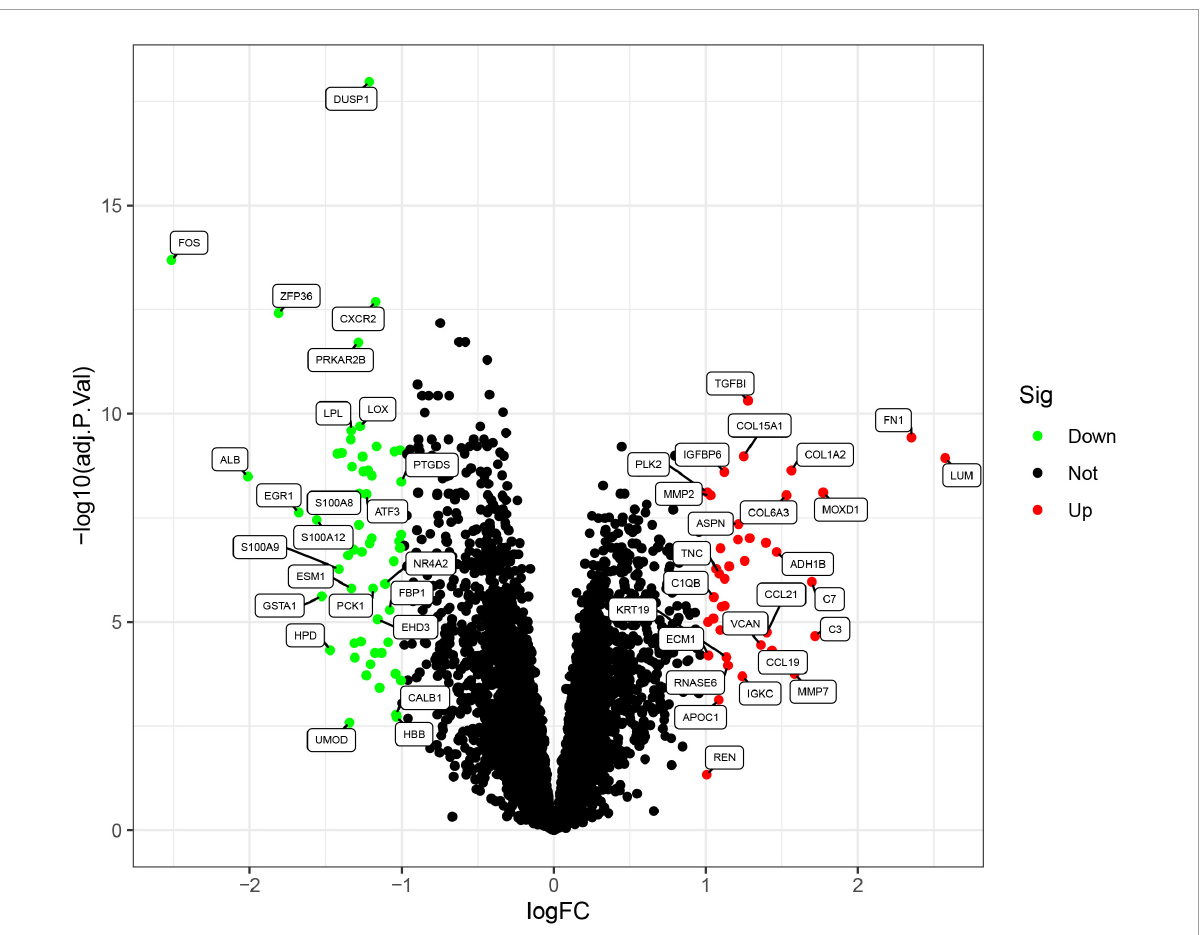
FIGURE2 Volcano plots of the differentially expressed genes. Red: genes upregulated in diabetic kidney disease (DKD); green: genes downregulated in